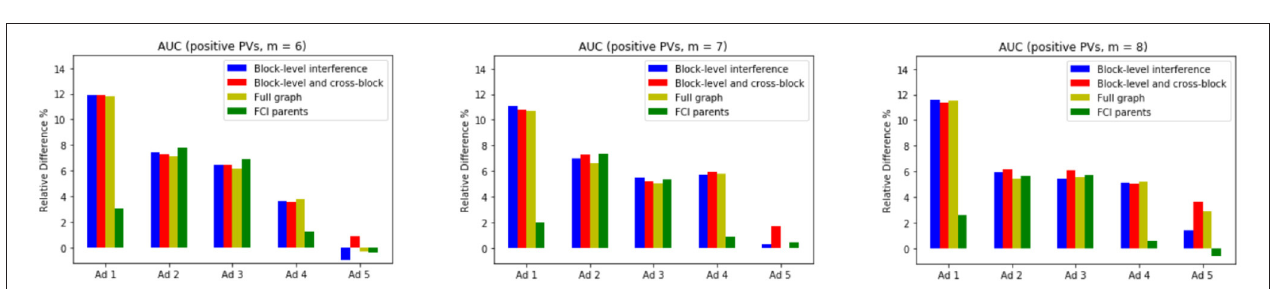
FIGURE 3 | Relative difference (in percentage) in AUCs with respect to the baseline model.